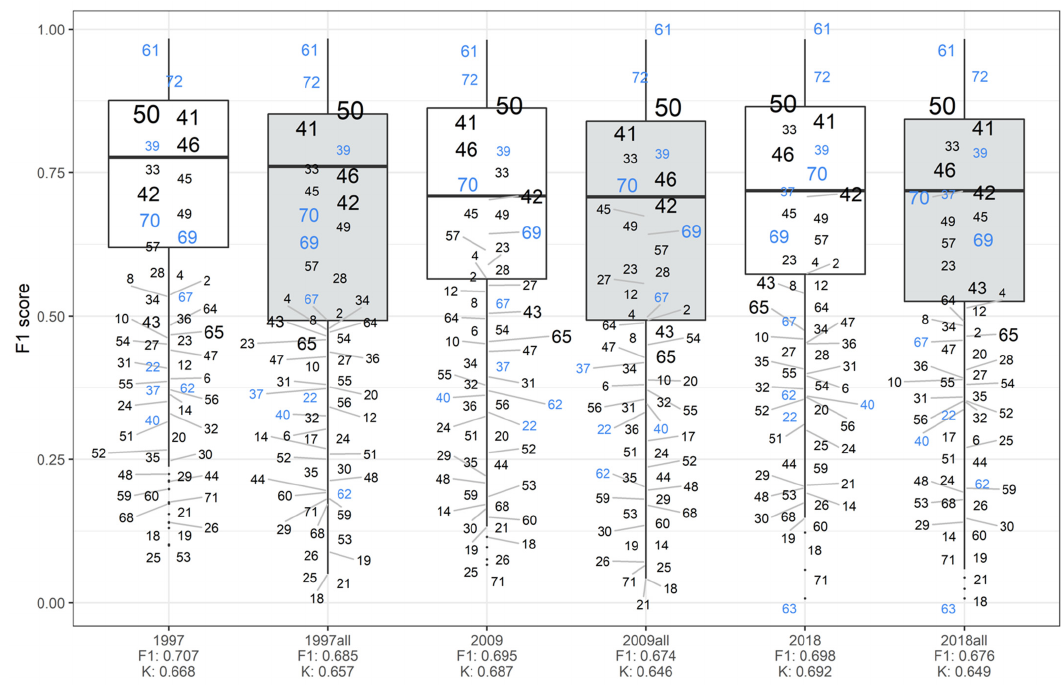
Figure 7. Weighted boxplots showing the F1-scores from the 72 downscaled classes (Landuse25) compared to the original classes (Landuse100), for each period, with (“all”) and without linear fea- tures. Numbers along the boxplots represent the land use categories and their size the proportion of each category in the dataset. Blue represents categories attributed based on “swisstopo” original classes; black represents categories attributed based on IDW of the 36 nearest neighbors. Values under each boxplot are overall weighted mean F1-score (F1) and kappa coefficient (k) for the con- sidered year and dataset. The percentages of misclassification for the downscaling of 2018 without linear fea- tures are represented in Figure 8. The major misclassifications concern unproductive grasslands (15%), farm pastures (12%), and meadows (10%). The classes in which the pix- els were misattributed are also presented (color in the box). This figure will help in under- standing the behavior of the downscaling algorithm to further improve it.